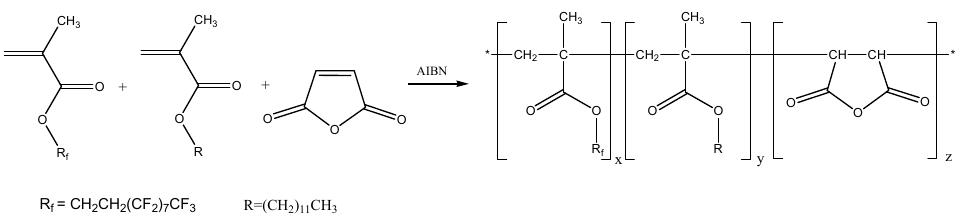
Scheme 4. Copolymerization of 1 H ,1 H ,2 H ,2 H -perfluorodecyl methacrylate with dodecyl methacrylate and maleic anhydride (x + y + z = 0.20 + 0.57 + 0.22 = 1).